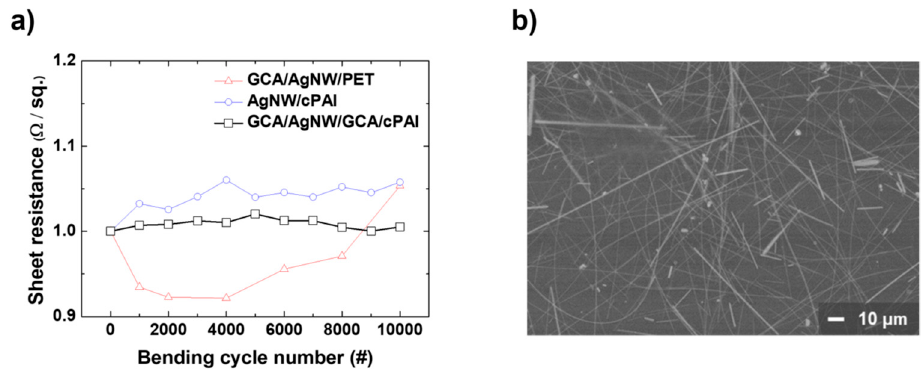
Figure 6. ( a ) Bending test of the GCA/AgNW/PET, AgNW/cPAI, and GCA/AgNW/GCA/cPAI-embedded electrodes, ( b ) SEM image after bending (10,000 times) of the GCA/AgNW/GCA/cPAI-embedded electrode.